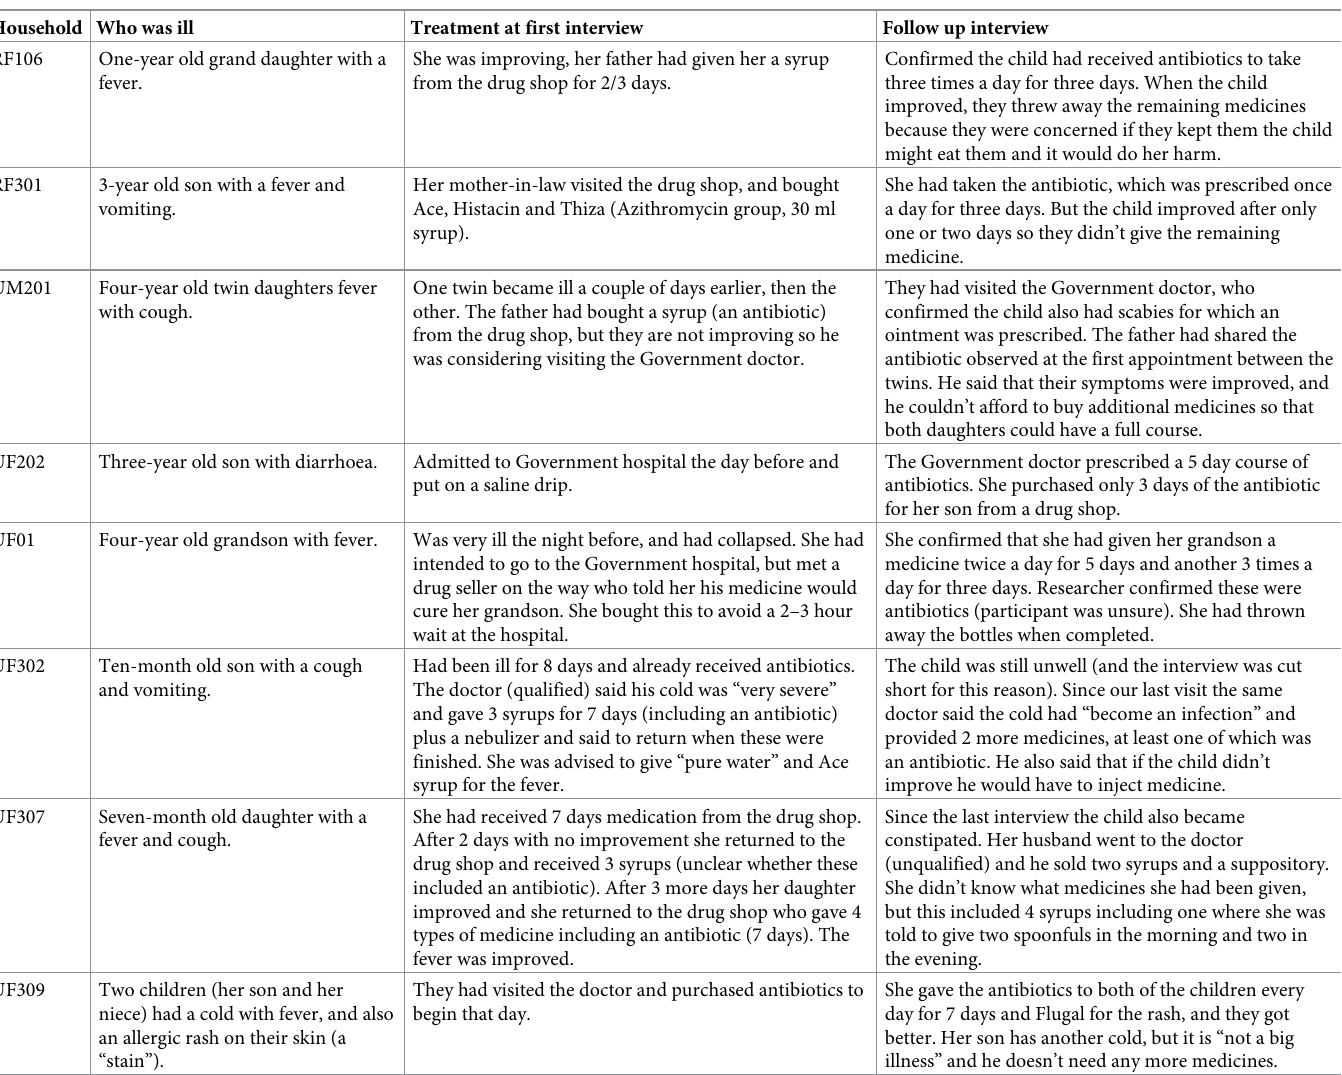
Table 2. Antibiotics use for current